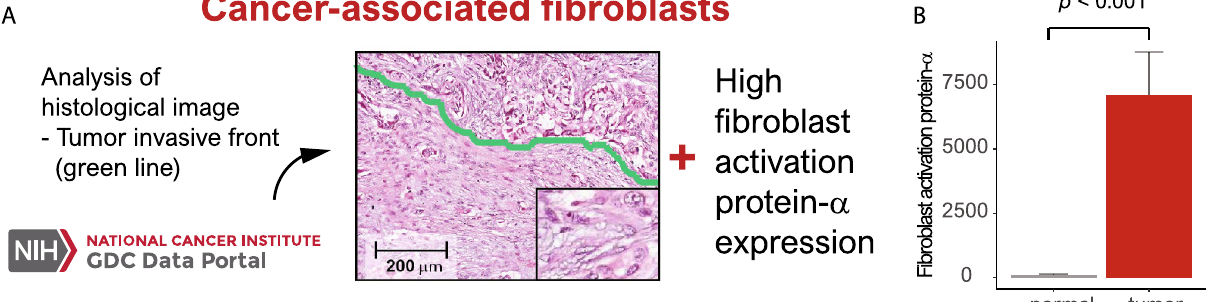
Figure 1. ( A ) Histological images showing cancer-associated fibroblasts at the tumor invasive front (green line) (inset: immature cancer-associated fibroblasts) (original magnification × 400; inset × 1000) and high fibroblast activation protein-α (FAP-α) expression. ( B ) Bar plots showing the difference in fibroblast activation protein-α expression between normal and tumor tissues ( p <